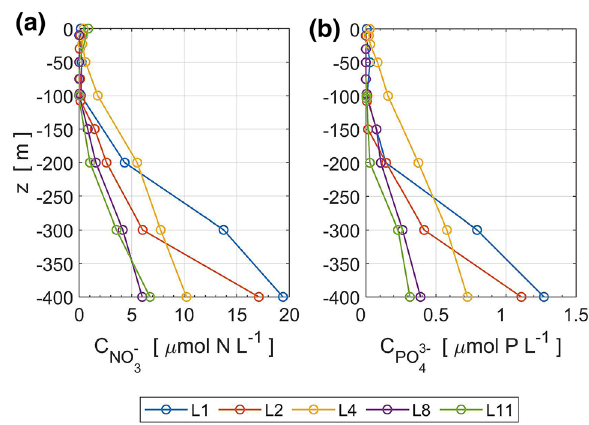
Figure 5. Vertical profiles of ( a ) nitrate and ( b ) phosphate obtained from water sampling at stations L1, L2, L4, L8, and L11 on 25–26